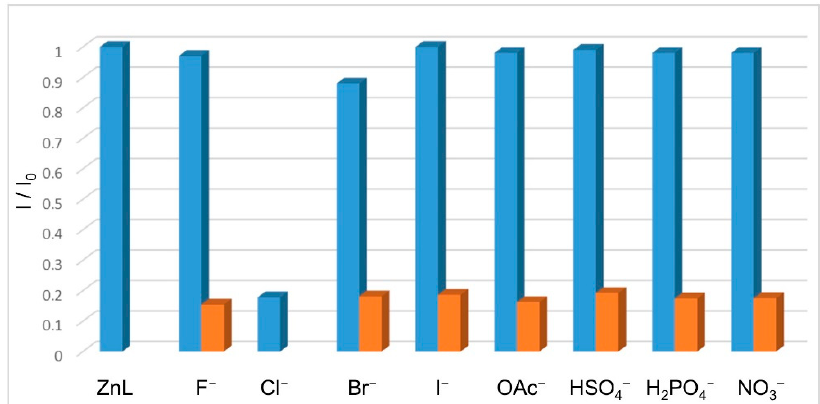
Figure 5. Plot of the ratio between the fluorescence emission intensity of [ZnL] 2+ complex at 374 nm ( λ ex = 277 nm) (I) and the emission intensity in the presence of 1 equiv. of F − , Cl − , Br − , I − , OAc − , HSO 4 − , H 2 PO 4 − , and NO 3 − anion (I 0 , blue bars), or in the co-presence of 1 equiv. of Cl − and 2 equiv. of F − , Br − , I − , OAc − , HSO 4 − , H 2 PO 4 − , and NO 3 − anions (as tetrabutylammonium salts, orange bars).